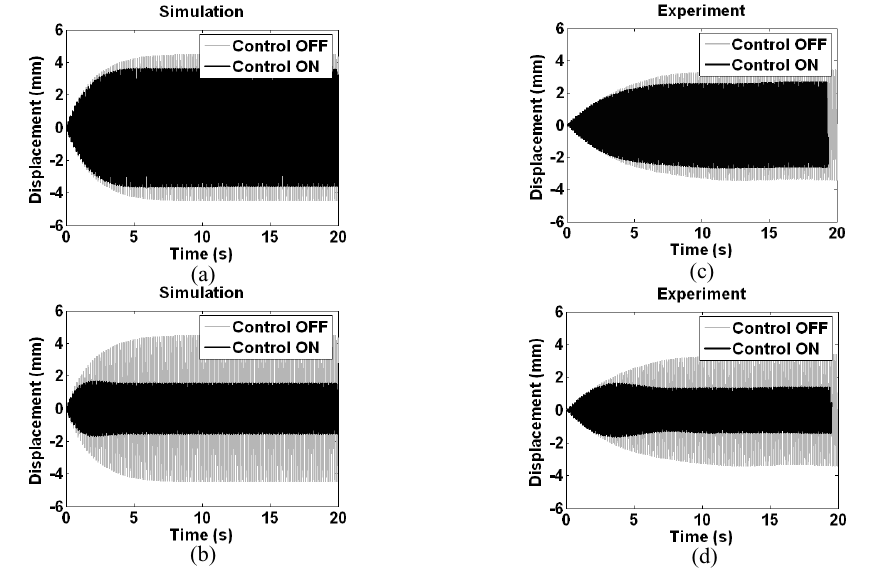
Fig. 12. Case 2 vibration responses for strain feedback control, simulation for (a) K p = 3.75 and (b) K p = 15, experiment for (c) K p = 3.75 and (d) K p = 15.